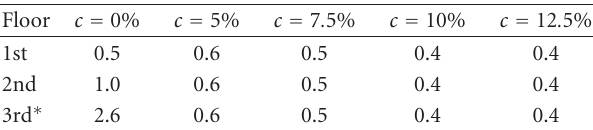
Table 3: Sway potential index calculated using the formula in (15) for the 4-storey building from Figure 3 designed to di ff erent proportions of lateral load ( c ).